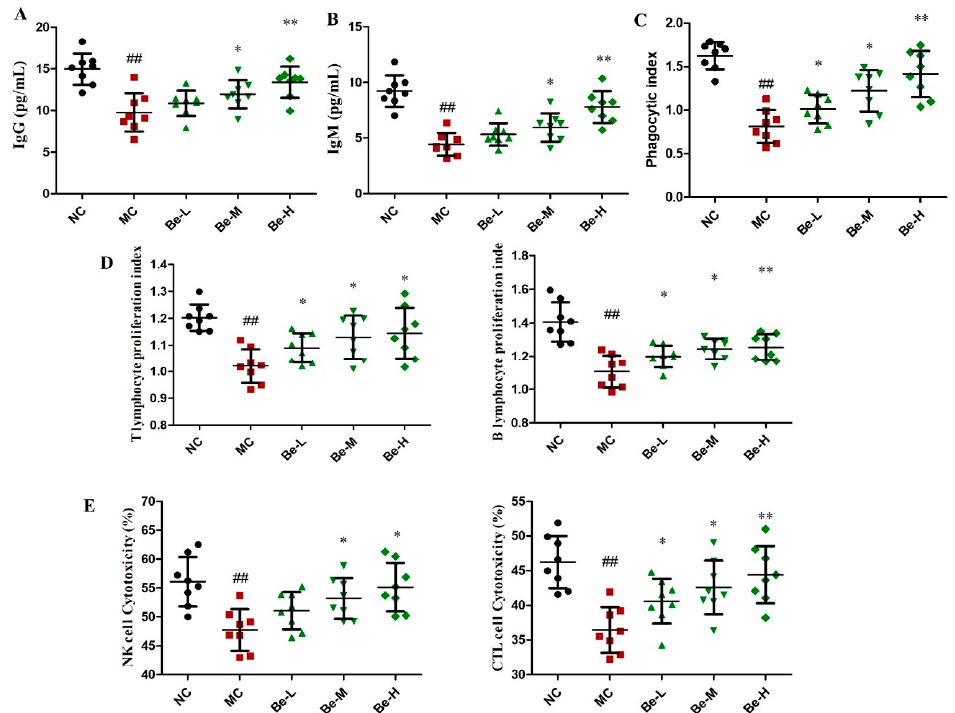
Figure 3. Effect of bergenin on immunoglobulin levels and immune cell activity in the Cy-treated mice. ( A ) Serum IgG levels; ( B ) Serum IgM levels; ( C ) Peritoneal macrophage phagocytosis; ( D ) Splenocyte proliferation induced by Con A and LPS; ( E ) Splenic NK and CTL cytotoxic activities. NC: normal control group, dosed with saline; MC: model control group, challenged with cyclophosphamide; Be-L: challenged with Cy and treated with 5 mg/kg/day bergenin; Be-M: challenged with Cy and treated with 10 mg/kg/day bergenin; Be-H: challenged with Cy and treated with 20 mg/kg/day bergenin. Data are expressed as mean ± SD ( n = 8). ## p < 0.01 vs. the NC group, * p < 0.05 and ** p < 0.01 vs. the MC group.